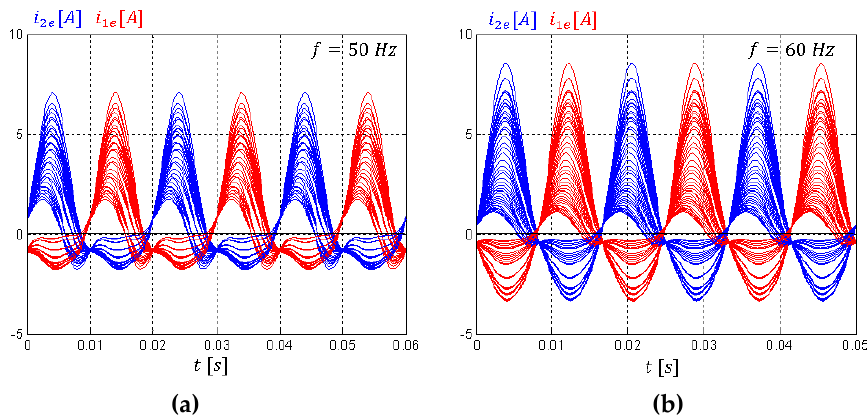
Figure 7. Evaluation of three cycles of the waveforms of the inductor currents for the entire ranges of input voltage and output load. ( a ) Standard 220 V @ 50 Hz and ( b ) standard 120 V @ 60 Hz.